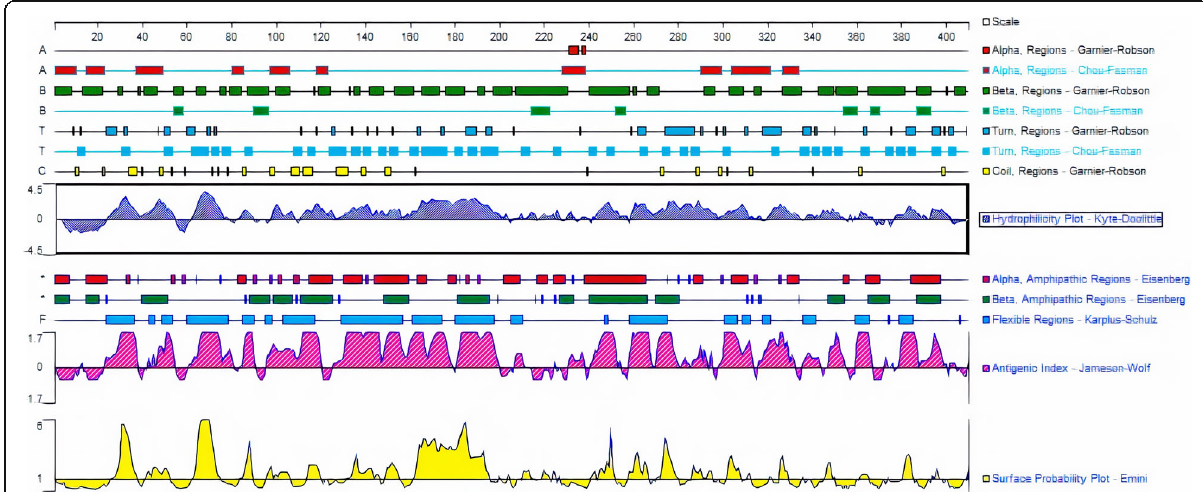
Fig. 4 Protein structure prediction using DNASTAR. Multiple peaks in the antigenic index contributes to a potential antigenic determinant of lysyl oxidase